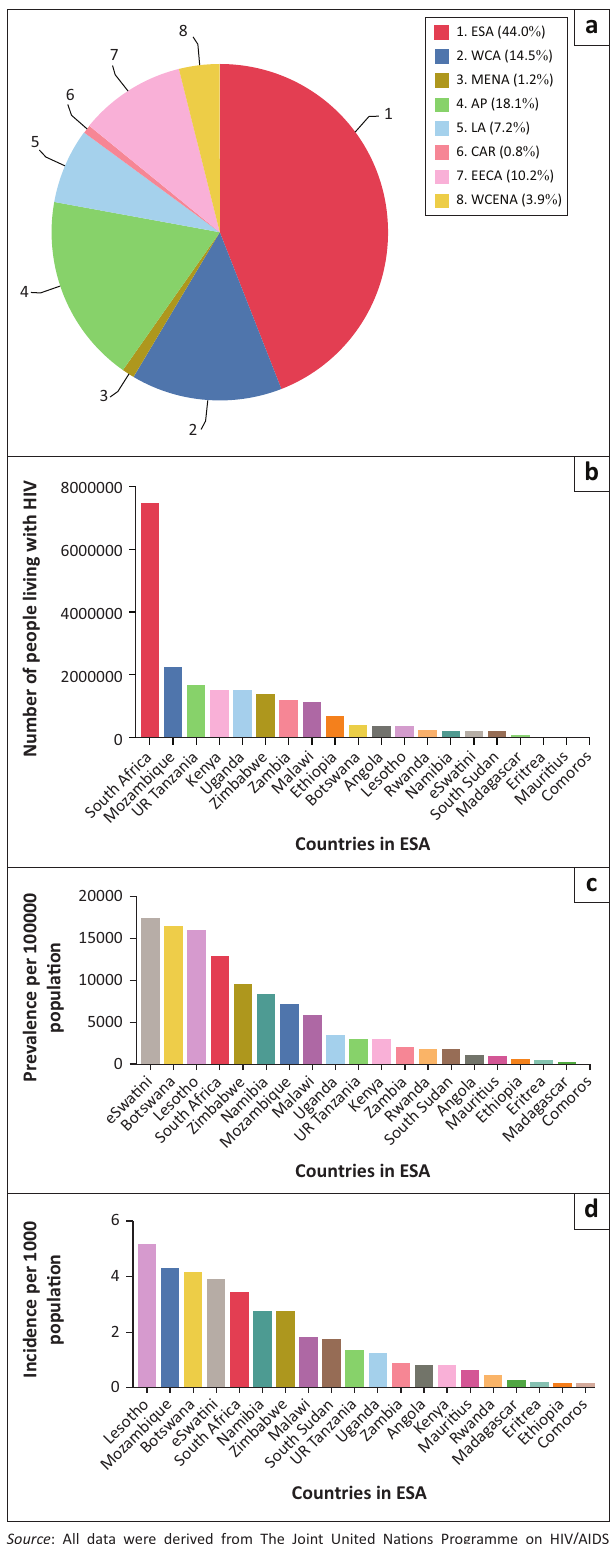
Source : All data were derived from The Joint United Nations Programme on HIV/AIDS (UNAIDS). UNAIDS Data 2020. Geneva: UNAIDS; 2020. Report No.: JC2997E; 2020 and United Nations, Department of Economic and Social Affairs, Population Division. New York, World population prospects 2019 [homepage on the Internet] [cited 2020 Aug 16]. Available from: https://population.un.org/wpp/ AP, Asia and the Pacific; CAR, Caribbean; EECA, Eastern Europe and Central Asia; ESA, Eastern and Southern Africa; LA, Latin America; MENA, Middle East and Northern Africa; WCA, Western and Central Africa; WCENA, Western and Central Europe and North America. FIGURE 1: (a) Worldwide distribution of new HIV infections identified by UNAIDS in 2019. (b) Distribution of people living with HIV infection in ESA in 2019. (c) Prevalence of HIV infection per 100 000 population among countries in ESA. (d) Incidence of HIV infection per 1000 population among countries in